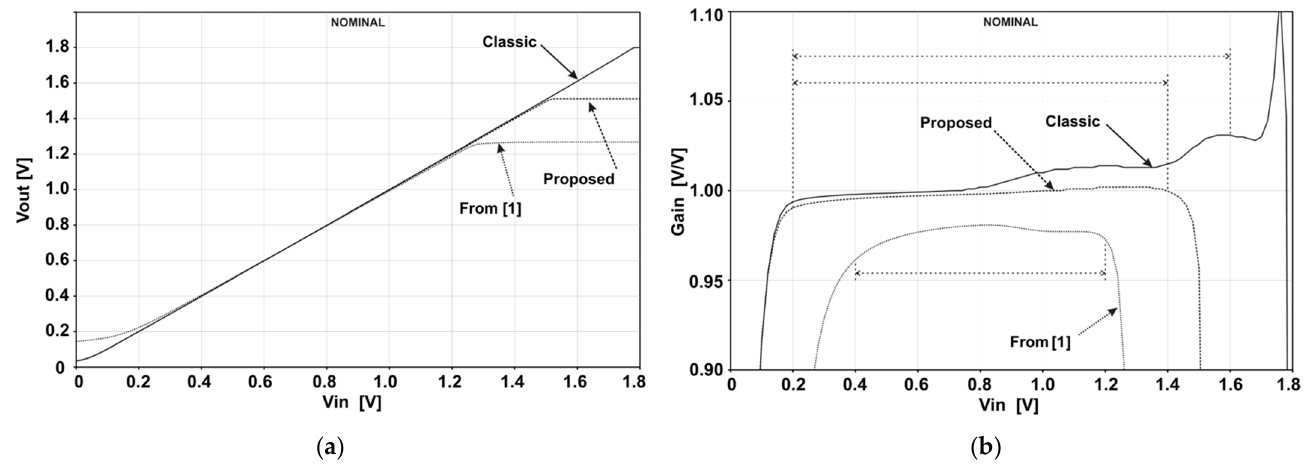
Figure 4. Simulated static characteristics: ( a ) V out vs. V in ; ( b ) Gain = d V out /d V in . Nominal (corner) models of transistors are used.